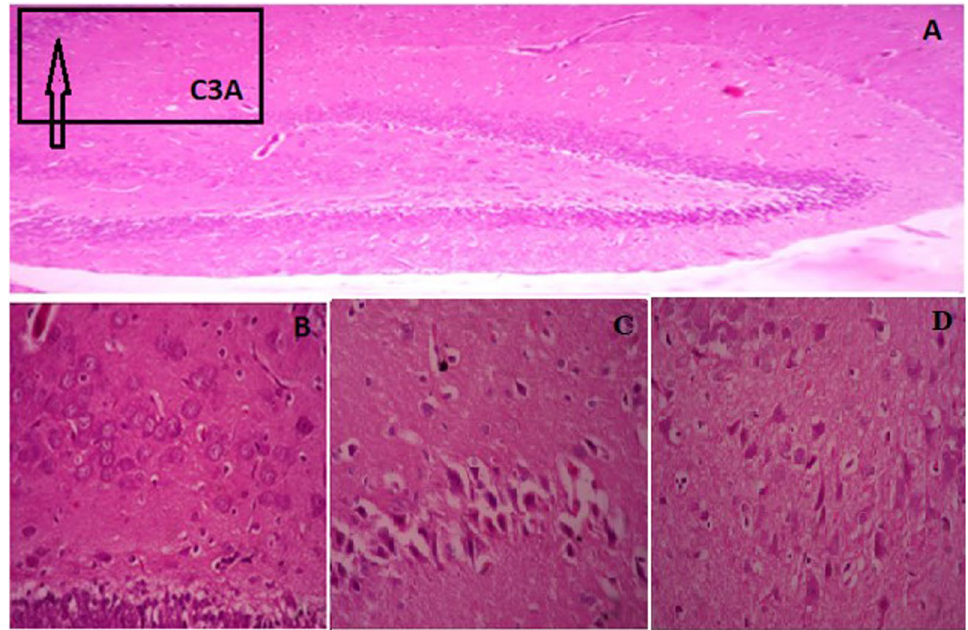
Fig. 7 A Photomicrograph: Hematoxylin and eosin staining of section of hippocampus at a magnification of 100 . ( B , C , D ) Higher magnification of C3A: B) Control group shows normal cells with multiple nuclei and no signs of necrosis or engorged blood vessels. C OVX group shows few pyramidal cells with shrunken apoptotic deeply stained nuclei with pericellular vacuolation with engorged blood vessels. D K 2 OVX group shows mostly normal pyramidal cells, very few deeply stained nuclei as a sign of degeneration. H&E ×